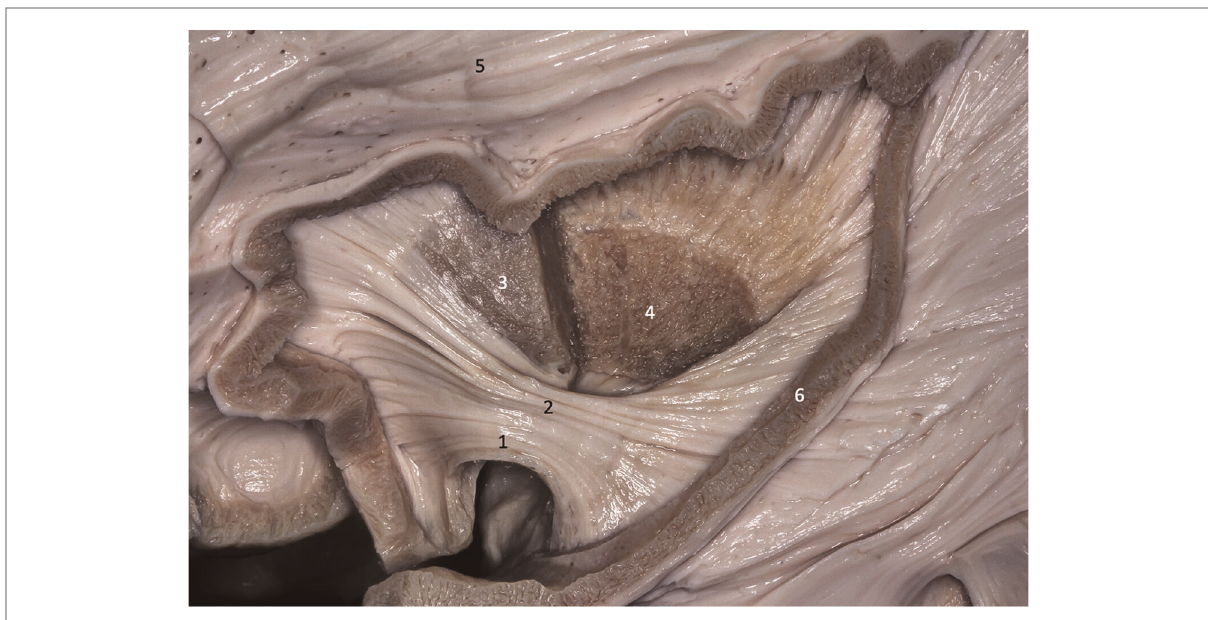
FIGURE 14 White fi bers dissection of left cerebral hemisphere. The IFOF and the uncinate fasciculus form the lateral boundary of the beginning of the lenticulostriate arteries emergence (not shown in this dissection) near the limen of the insula. 1 - uncinate fasciculus; 2 - inferior fronto-occipital